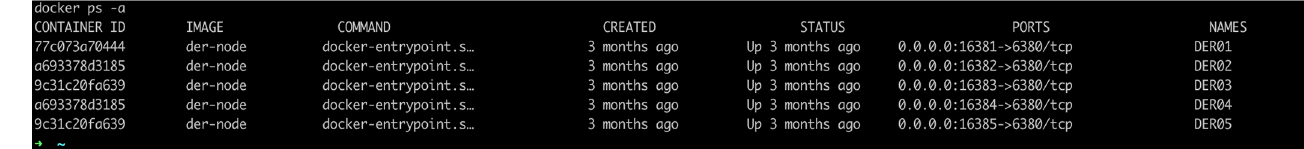
Figure 10. The deployment of projects based on docker.